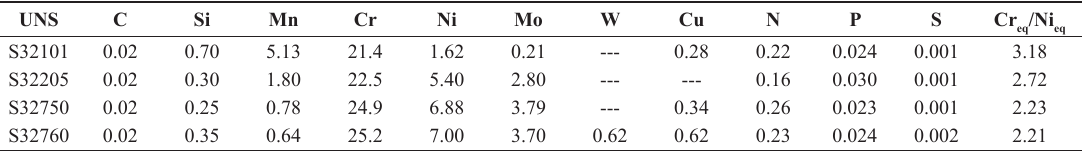
Table 1. Chemical compositions of the alloys (wt. %).